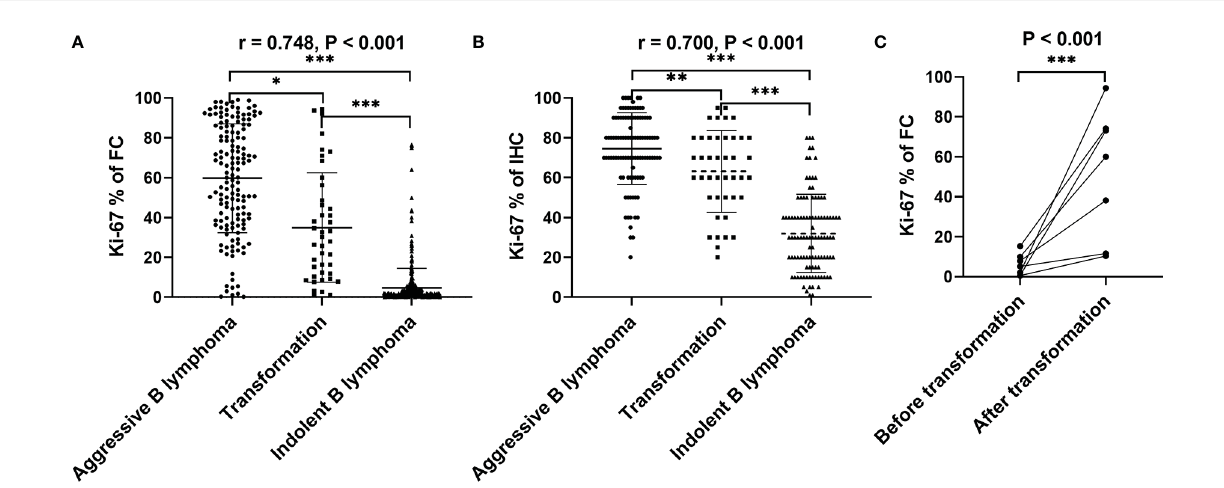
FIGURE 3 The difference of KI67 expression among aggressive lymphoma, transformed lymphoma and indolent lymphoma. (A) The positive rate of Ki67 expression by MFC was signi fi cantly different in aggressive B-cell lymphoma, indolent B-cell lymphoma, and transformed B-cell lymphoma. And among the 3 groups of lymphoma, the expression positive rate of Ki67 by MFC was highest in the aggressive lymphoma group, followed by the transformed lymphoma, and the lowest was the indolent lymphoma. (B) Pathologically IHC detected Ki67 PI was signi fi cantly different in aggressive B-cell lymphoma, indolent B-cell lymphoma, and transformed B-cell lymphoma. Among the 3 groups of lymphoma, the expression positive rate of Ki67 by IHC also was highest in the aggressive lymphoma group, followed by the transformed lymphoma, and the lowest was the indolent lymphoma. (C) The positive rate of Ki67 expression in the same patient gradually increased with the progression and transformation of the disease. *p < 0.05, **p < 0.01, ***p <